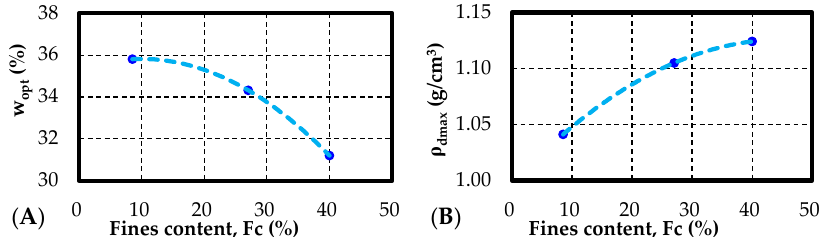
Figure 3. Compaction curve of test samples in this study, according to the A-b method [28].